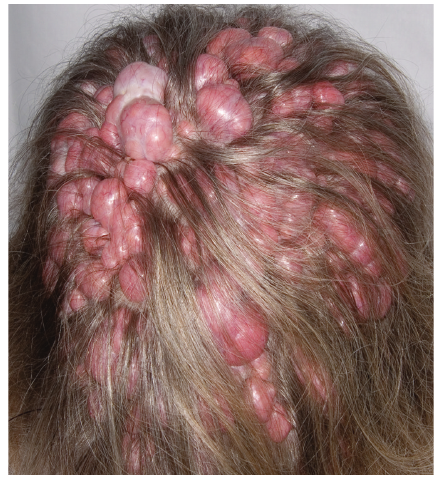
Figure 6: Clinical photographs of the multiple scalp